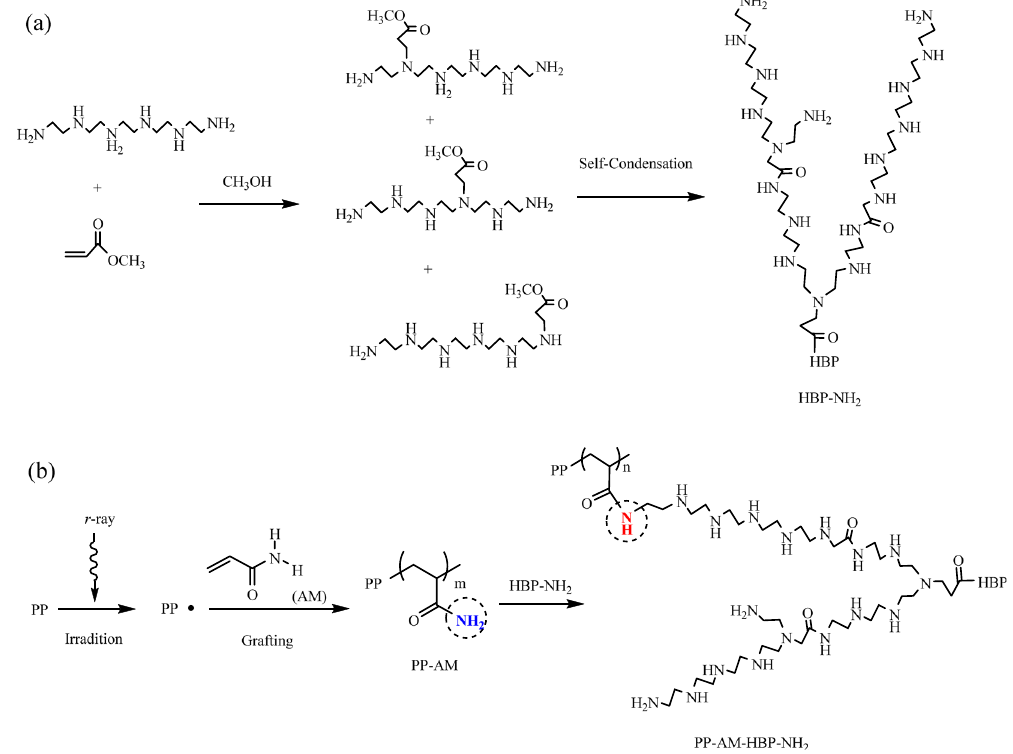
Figure 1. Reaction scheme of HBP-NH 2 preparation ( a ) and PP-AM-HBP-NH 2 preparation ( b